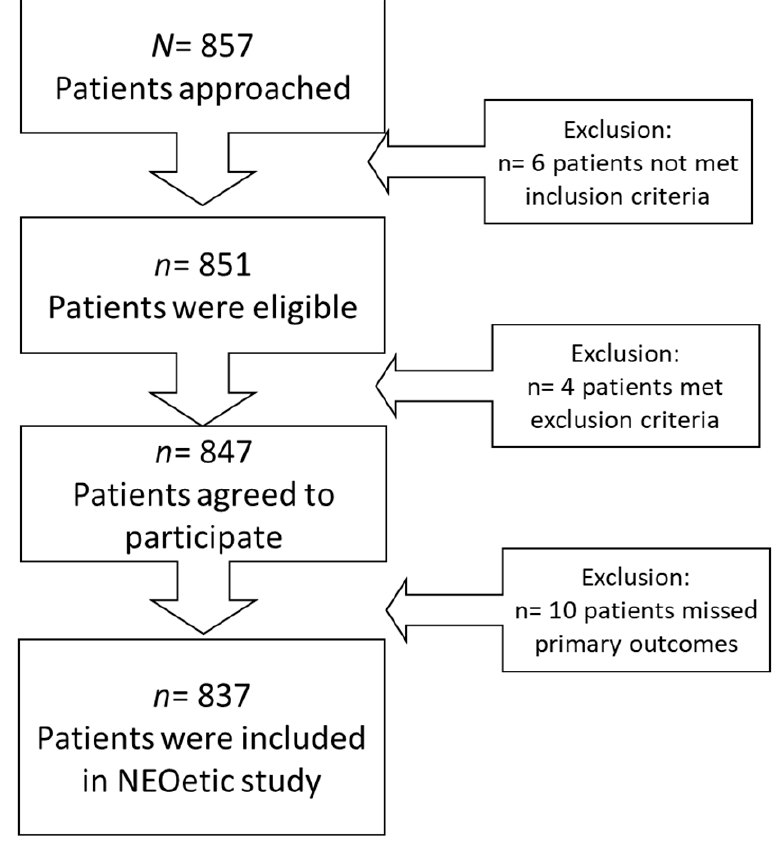
Figure 1. Flow diagram of the NEOetic study.